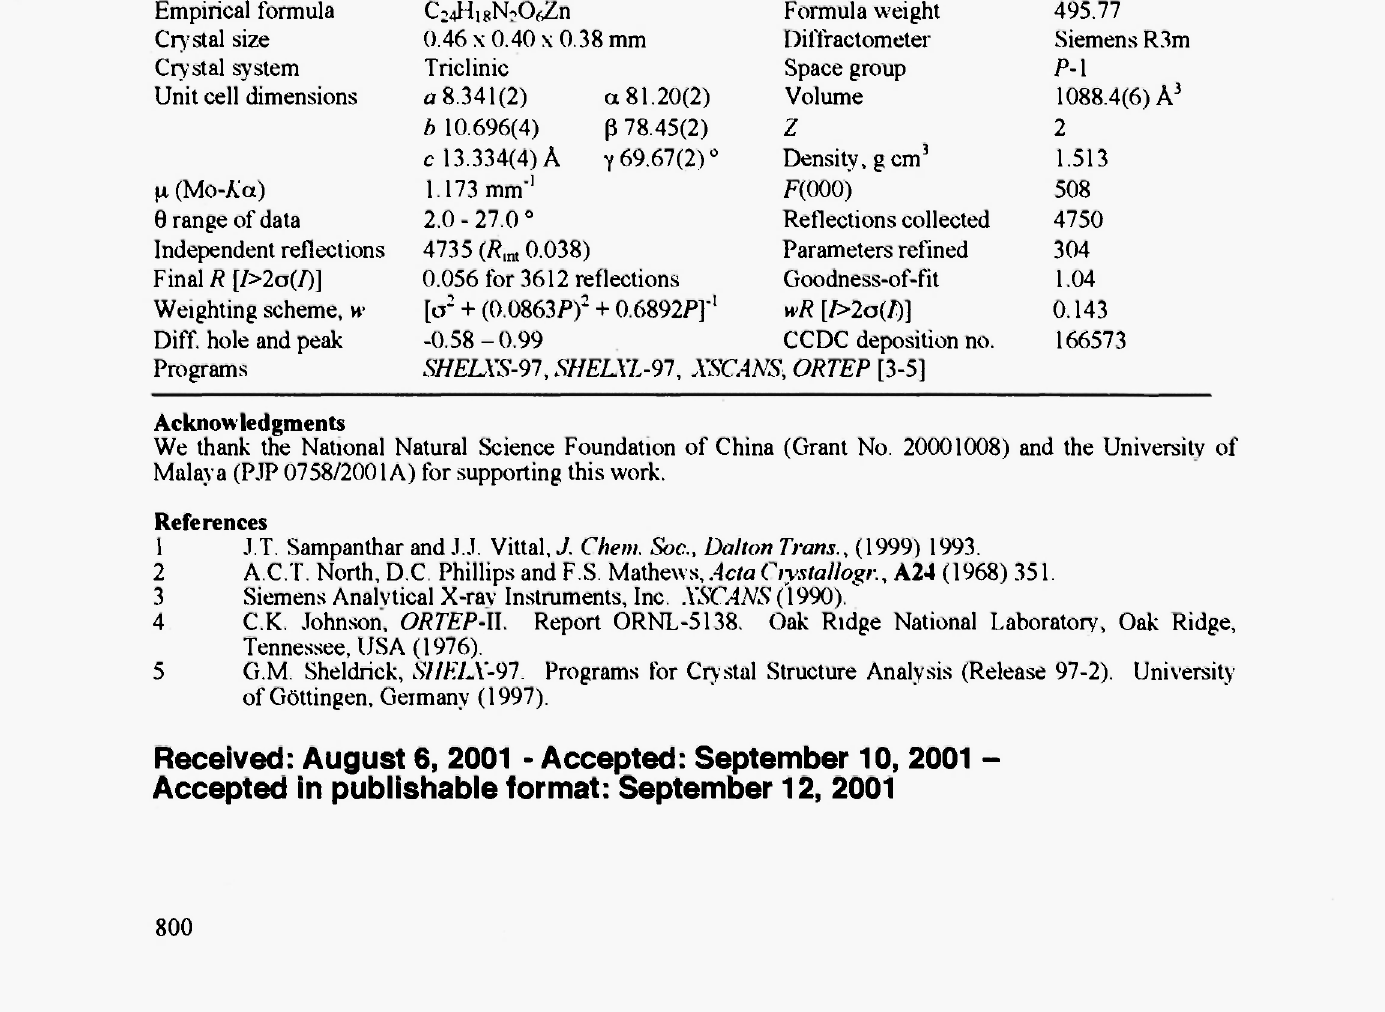
Table 1. Crystal data for